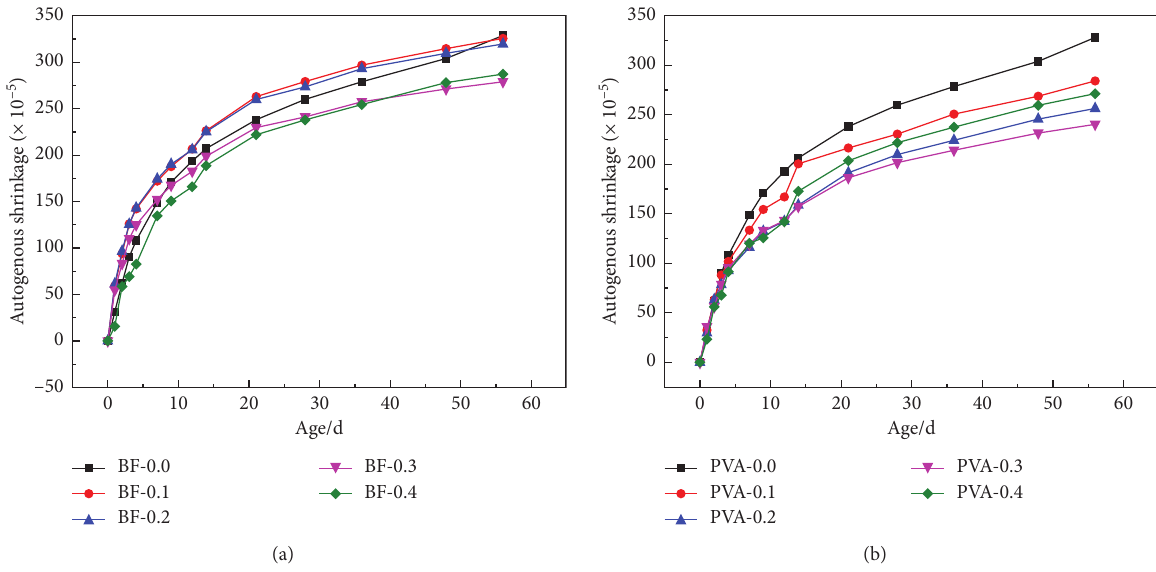
Figure 6: Effect of content of (a) basalt fibres and (b) PVA fibres on the autogenous shrinkage rate of geopolymer